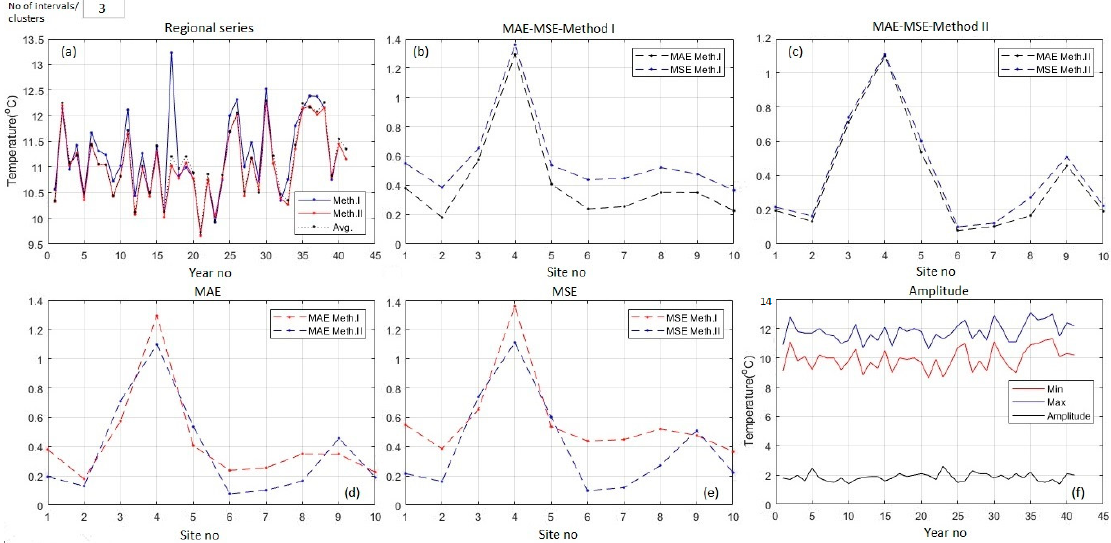
Figure 8. The case of three intervals/clusters for the series of average temperatures: ( a ) the regional series, ( b ) MAE and MSE—Method I; ( c ) MAE and MSE—Method II; ( d ) comparisons of MAEs; ( e ) comparisons of MSEs; ( f ) min, max, and amplitude of the average temperatures series.